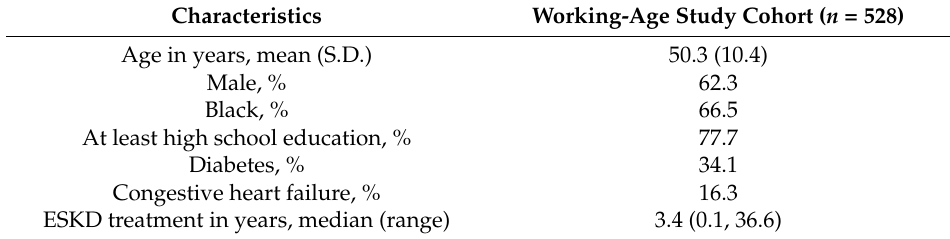
Table 2. Characteristics of HD patients aged 20–64 in the USRDS AAS at the time of baseline evaluations 2009–2011.